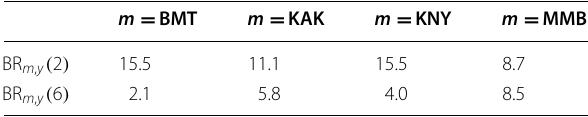
Table 4 BR m , y ( 2 ) and BR m , y ( 6 ) of BMT, KAK, KNY, and MMB in 2004